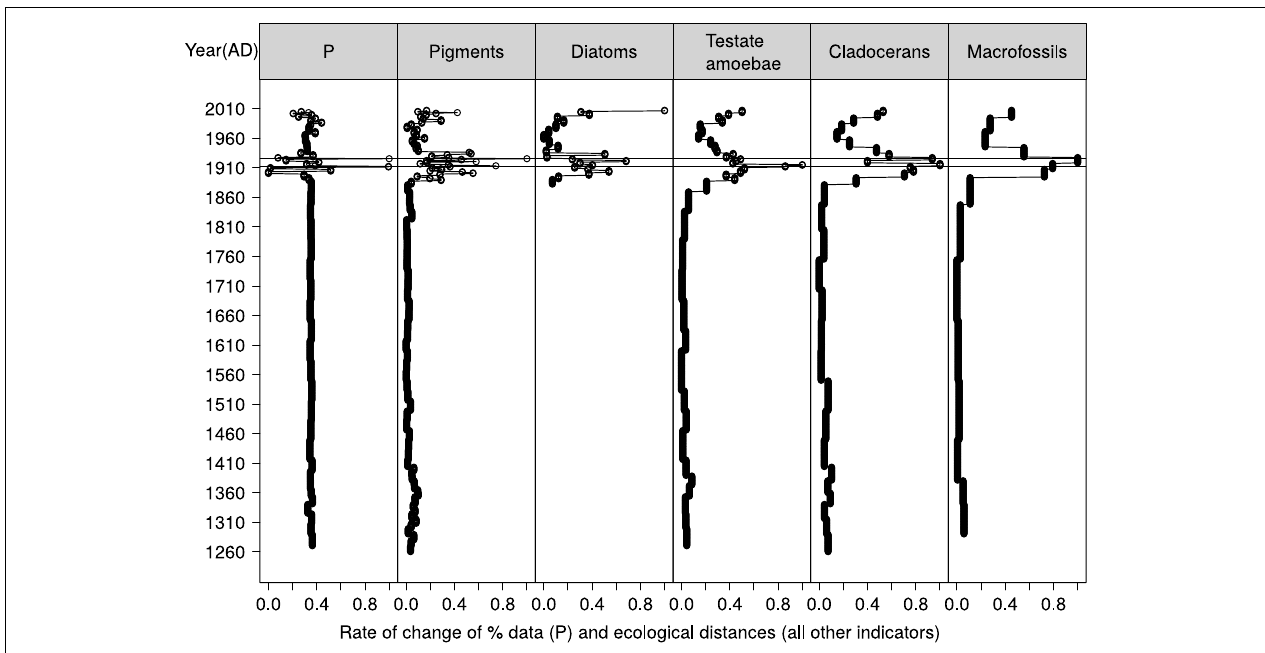
FIGURE 7 | Rate of change in P and ecological distances between consecutive samples of biological groups, ranged between 0 and